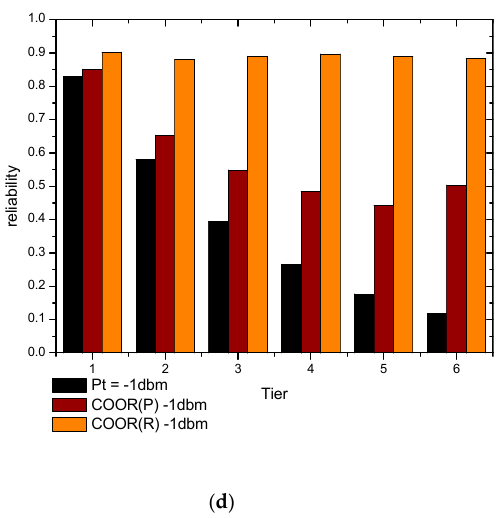
Figure 18. ( a ) End-to-end reliability of different region under r = 60, N = 2; ( b ) End-to-end reliability of different region under r = 70, N = 3; ( c ) End-to-end reliability of different region under r = 80, N = 4; ( d ) End-to-end reliability of different region under r = 90, N = 4.